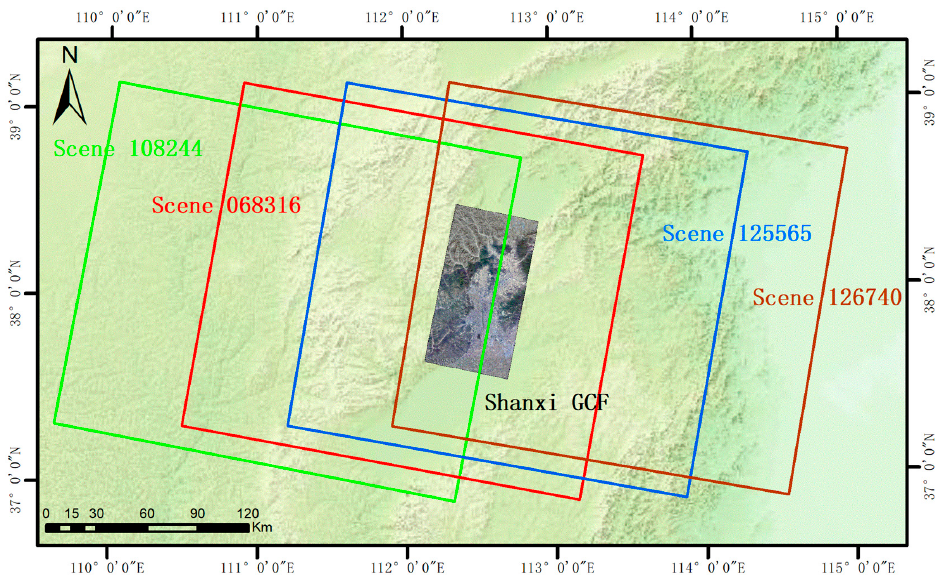
Figure 3. Coverage of images 108244, 068316, 125565, and 126740 and the GCF in Shanxi. Remote Sens. 2018 , 10 , 98